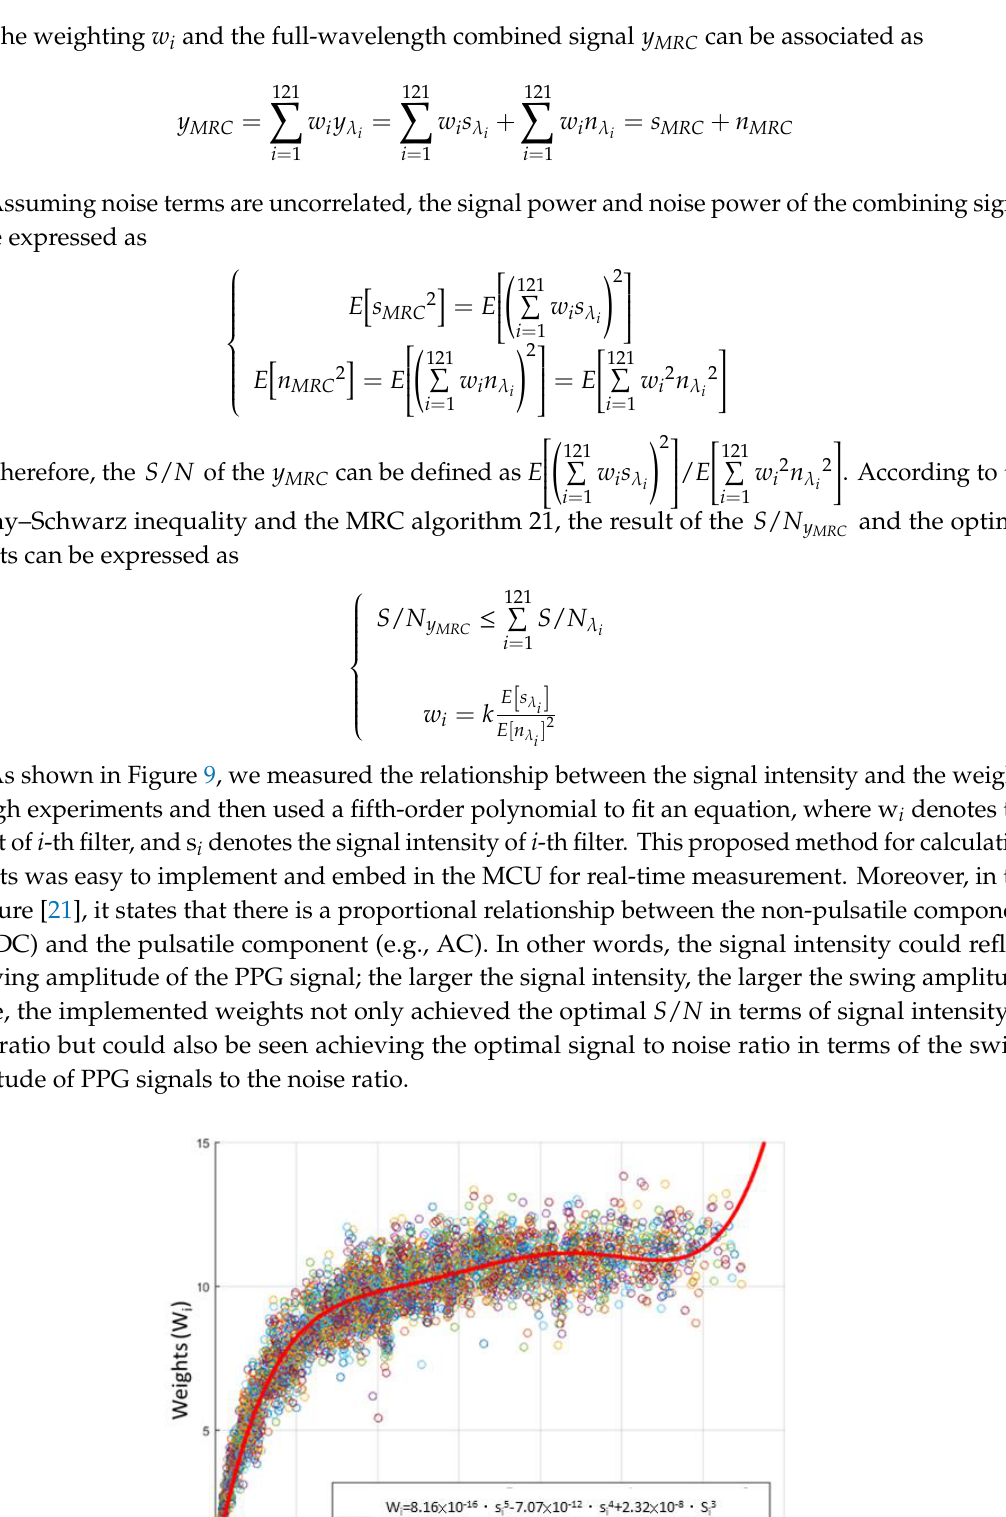
− 7.07 × 10 − 12 · s 4 i i